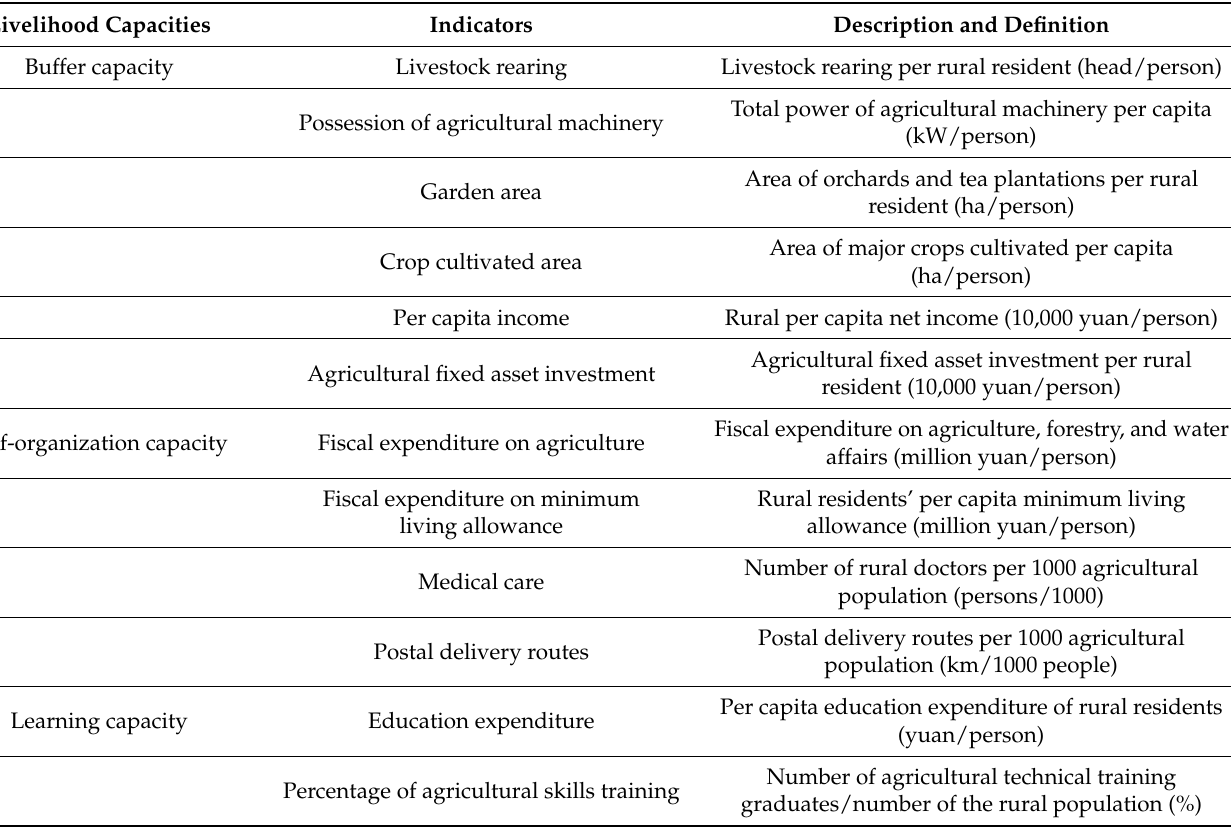
Table 1. Definitions and units of measurement of the indicators of the livelihood resilience of rural